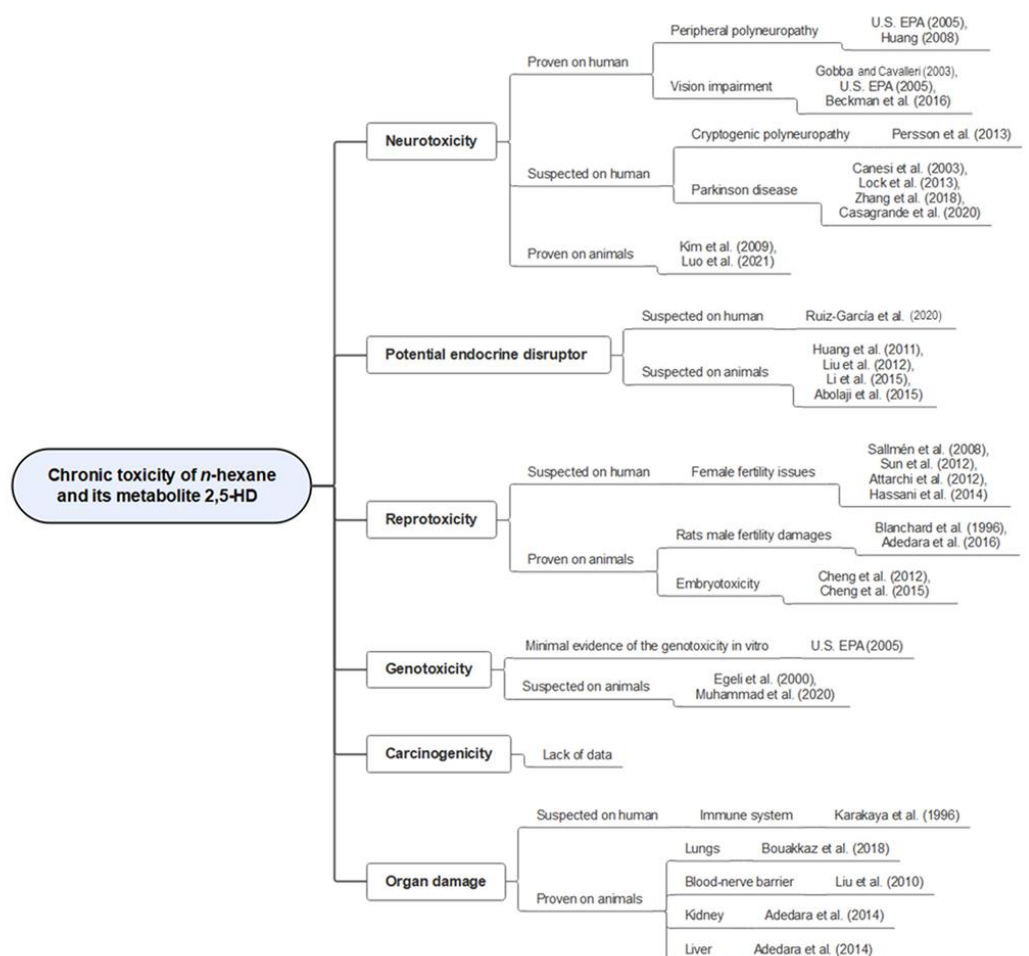
Figure 4. Chronic toxicity of n -hexane and its metabolite 2,5-HD [24,25,47,63 – 89].